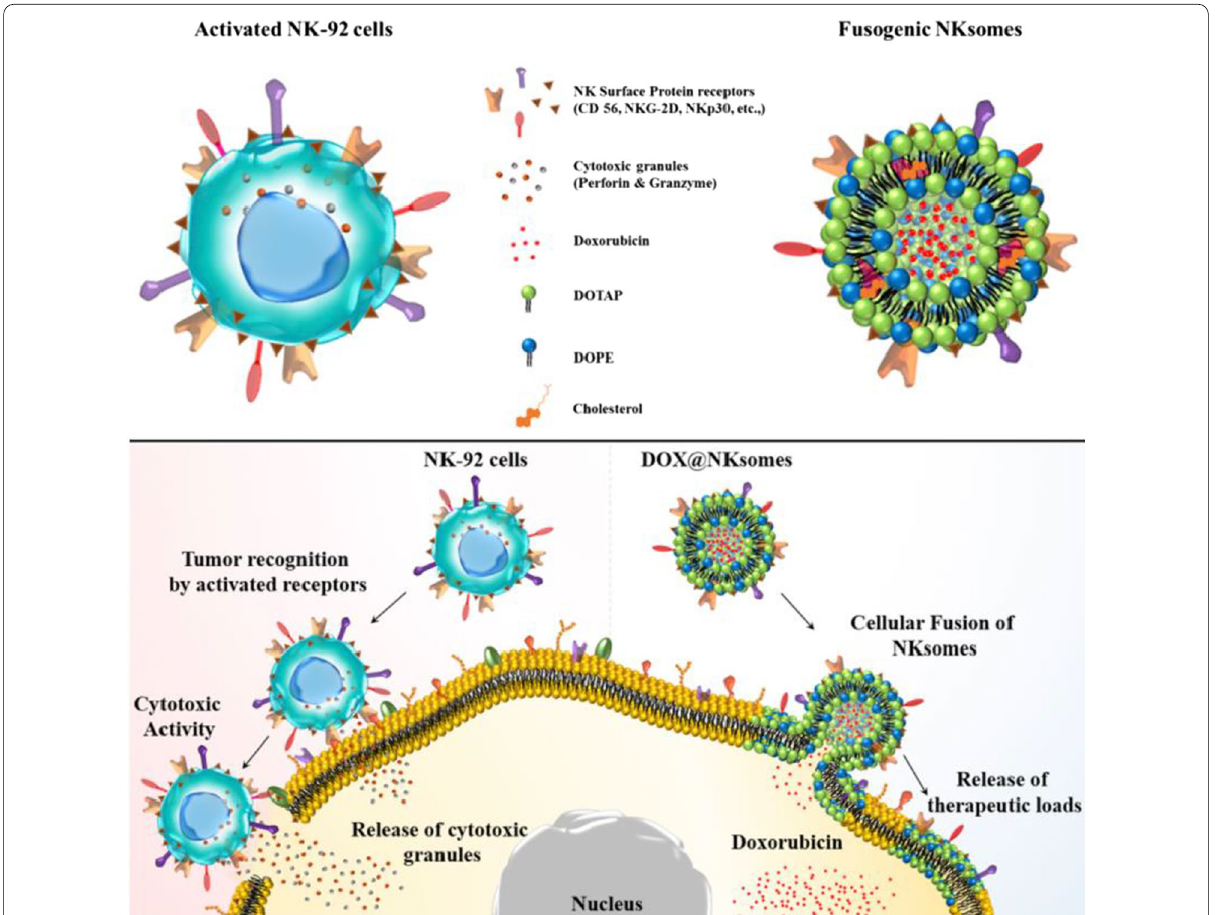
Fig. 5 Schematic illustration of activated NK cells (NK-92 cells) and NK-92 cell membrane-derived fusogenic liposomes (NKsomes) for targeted tumor therapy [63]. Copyright 2018 Elsevier